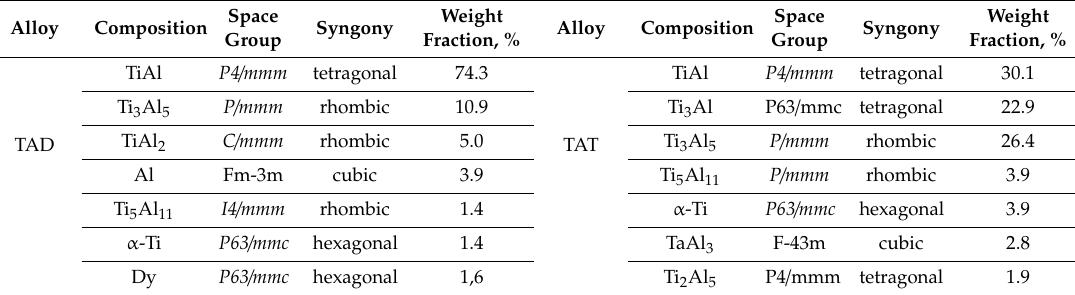
Table 9. Crystallographic data of phases in the TAD and TAT